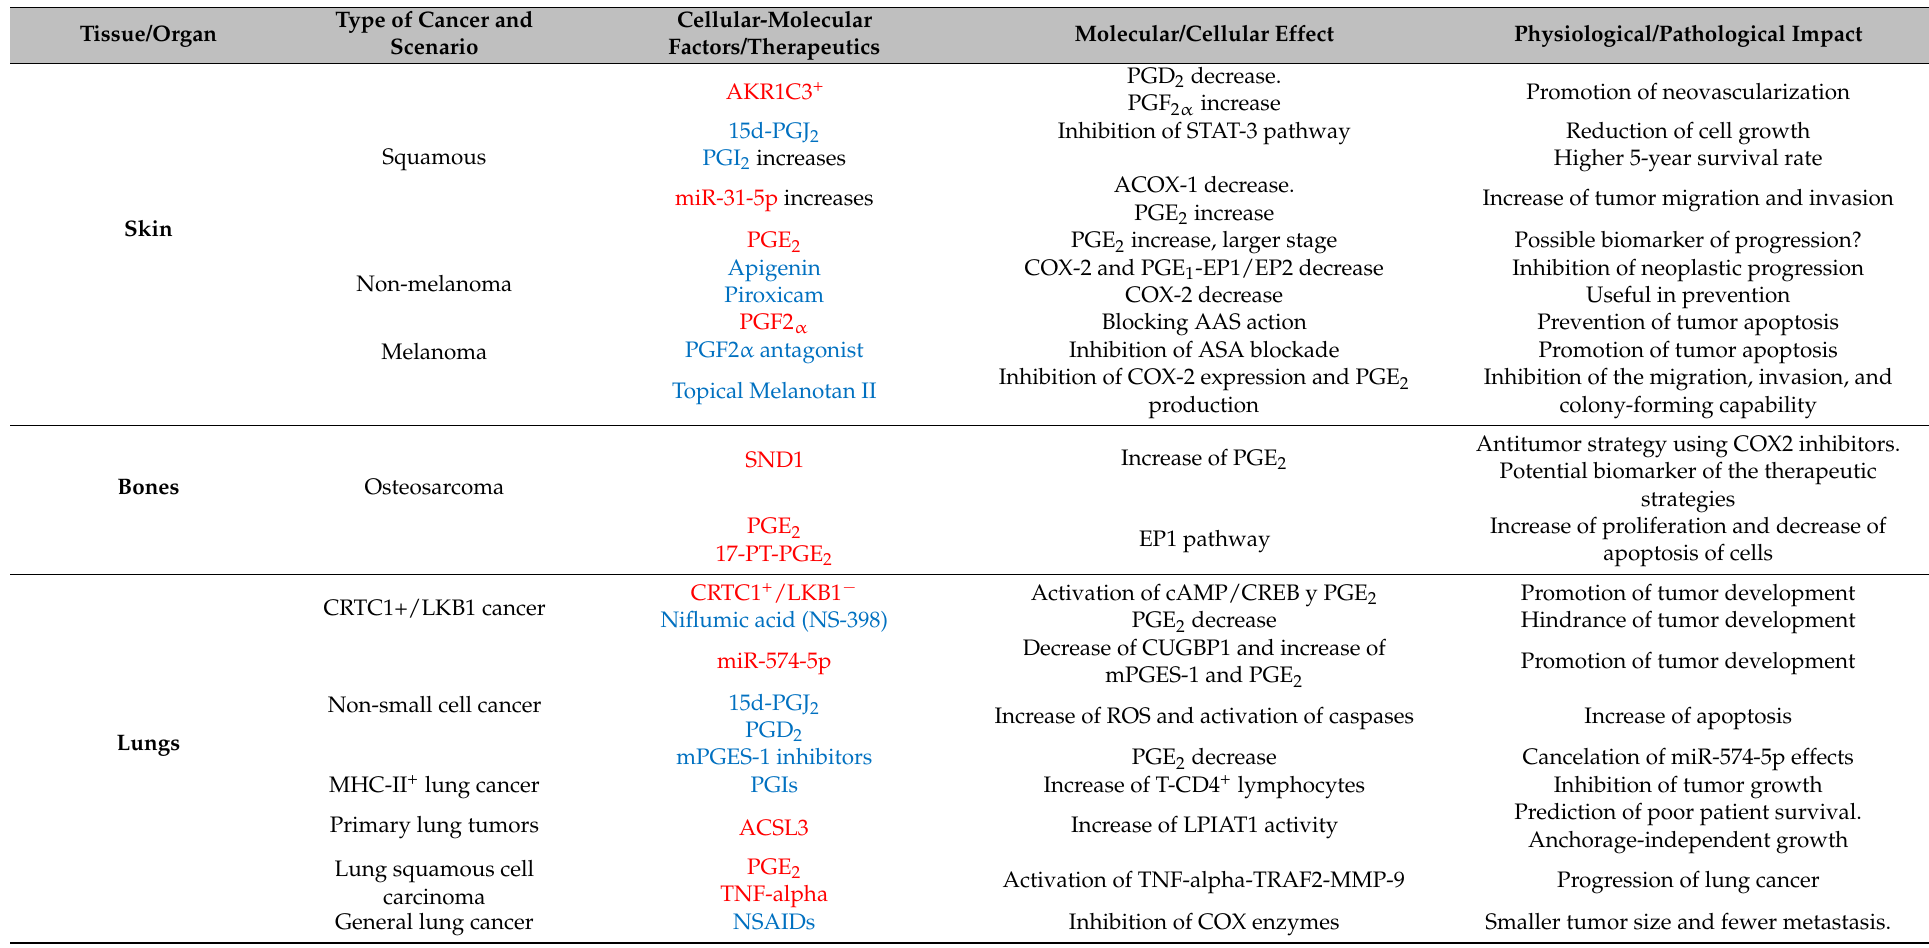
Table 2. Summary of the role of prostaglandins in cancer. In red: cellular, molecular factors or treatments that promote the development of cancer. In blue: cellular, molecular factors or treatments that hinder tumor